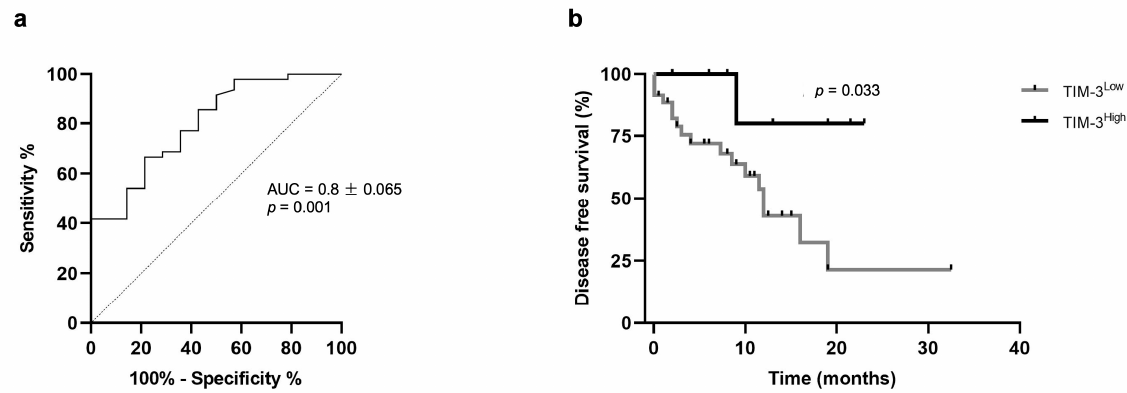
Figure 6. Prognostic value of serum TIM-3 levels. ( a ) Receiver operator curve (ROC) analysis of sensitivity versus specificity for serum TIM-3: AUC 0.8 ± 0.065 (95% CI: 0.674–0.929, p = 0.001; sensitivity = 66.7%; specificity = 78.6%). ( b ) Kaplan–Meier survival curve for serum TIM-3: Disease-free levels ( p = 0.033). The highest quartile was used as a